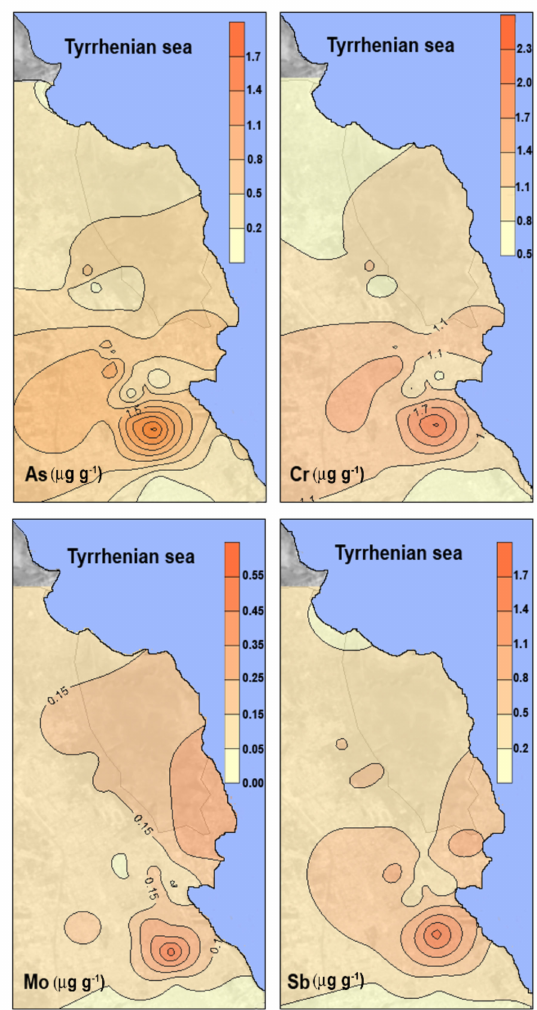
Figure 4. Areal distribution maps of As, Cr, Mo, and Sb in F. macrophylla leaves. Data are expressed in µ g g − 1 (dry